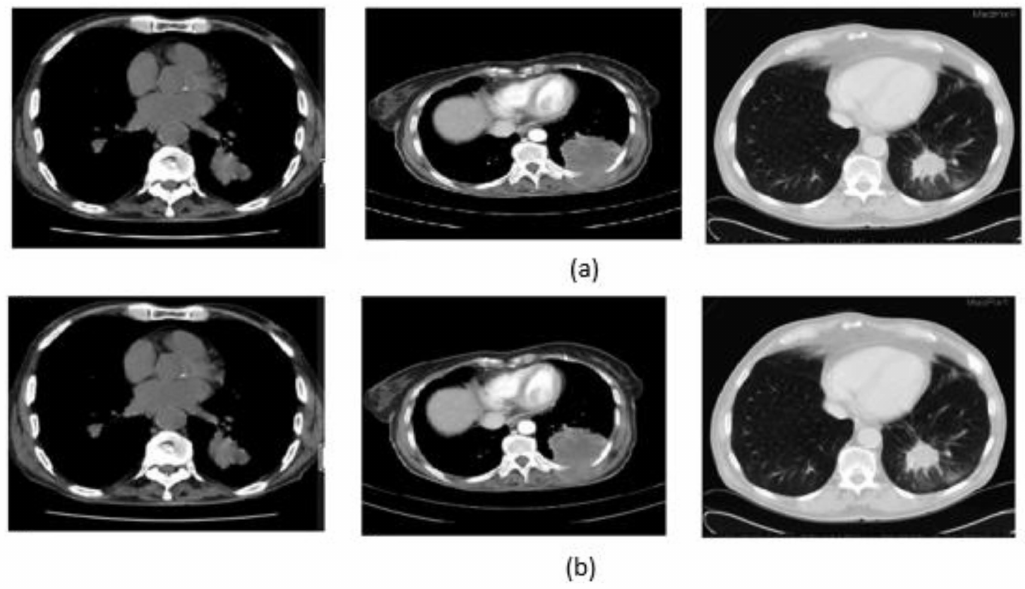
Figure 4. Output of the pre-processed images: ( a ) the lung CT images ( b ) Gabor filter enhancement.